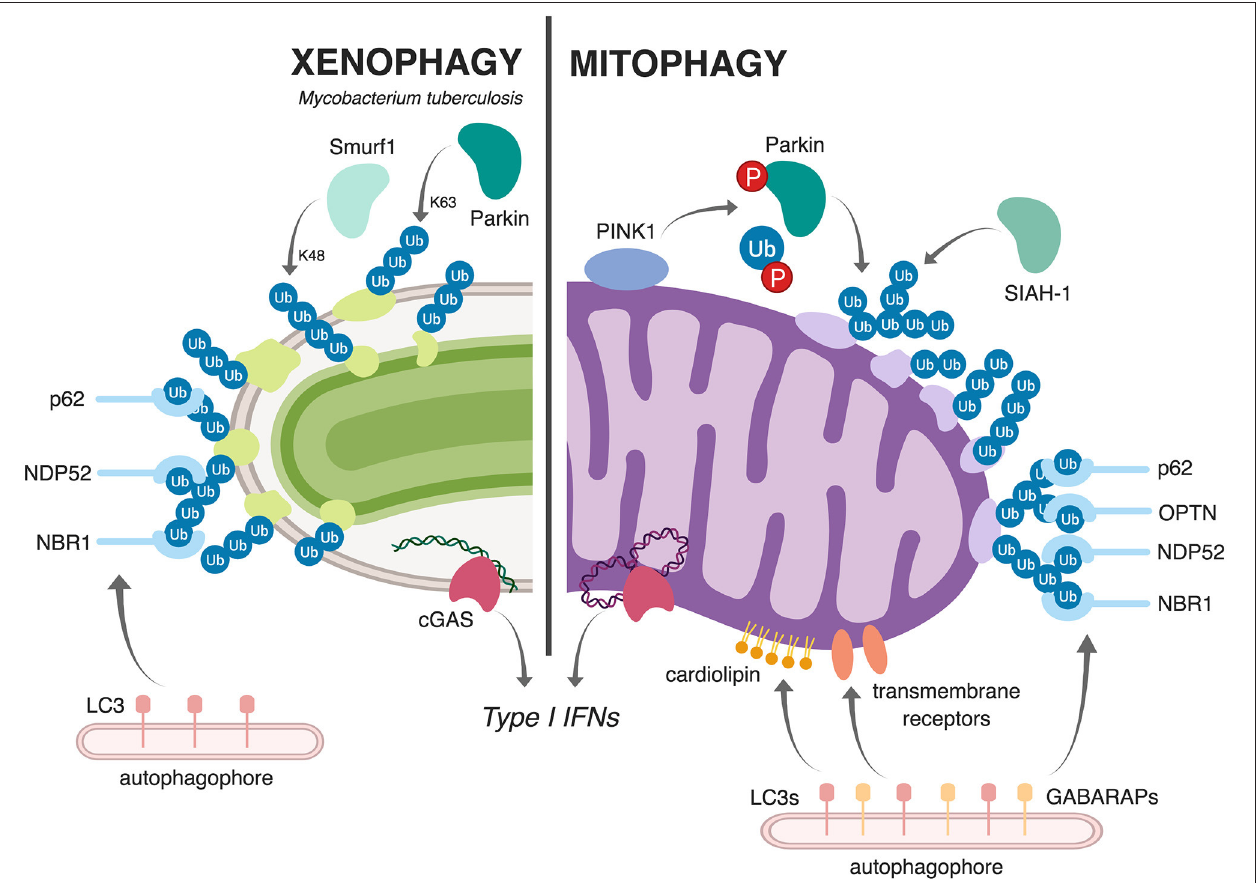
FIGURE 2 | Schematic representation comparing and contrasting mitophagy and xenophagy of Mtb. During xenophagy of Mtb in macrophages (left) , Mtb-containing vacuoles are decorated with ubiquitin via the E3 ligases Parkin ( Watson et al., 2012) and Smurf1 (Franco et al., 2017). This recruits various selective autophagy adaptors (p62, NDP52, and NBR1) and, subsequently, LC3 and the autophagophore. Upon mitochondrial damage (right) , the kinase PINK1 phosphorylates both Parkin and ubiquitin ( Kondapalli et al., 2012; Kane et al., 2014; Koyano et al., 2014; Kazlauskaite and Muqit, 2015), allowing Parkin to ubiquitinate mitochondrial proteins. The E3 ligase SIAH1 also contributes to the ubiquitination of mitochondrial proteins ( Szargel et al., 2016). As in xenophagy, this ubiquitination recruits selective autophagy adaptors (p62, OPTN, NDP52, and NBR1), LC3, and the autophagophore. Other ubiquitin-independent mechanisms, like cardiolipin-dependent mitophagy and receptor-mediated mitophagy, can also target damaged mitochondria to autophagy; in these pathways, exposed cardiolipin or outer membrane proteins directly recruit LC3 proteins or the closely related GAPARAP proteins. Both Mtb infection and mitochondrial damage activate the cytosolic DNA sensor cGAS (bottom) , which elicits a type I IFN transcriptional program (Wassermann et al., 2015; Watson et al., 2015; West et al., 2015; Franco et al., 2017). Figure created with